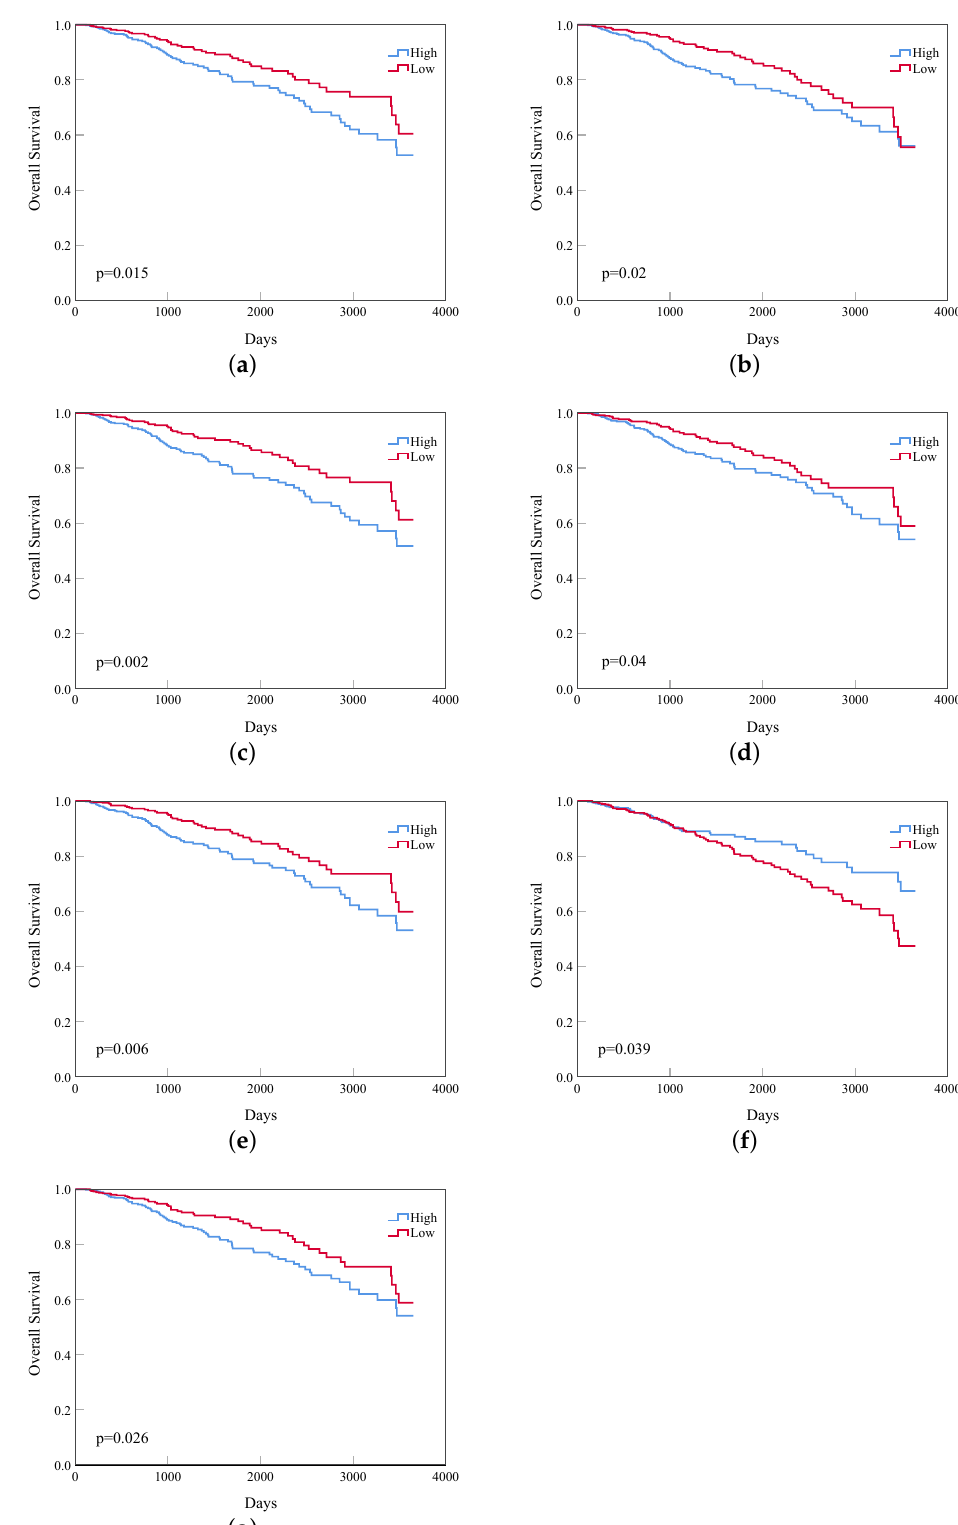
Figure 6. The remaining 7 genes’ survival curves of the top 20 genes. ( a ) KIF23; ( b ) CCNB2; ( c ) KIF4A; ( d ) MELK; ( e ) RAD51; ( f ) HRAS; ( g )